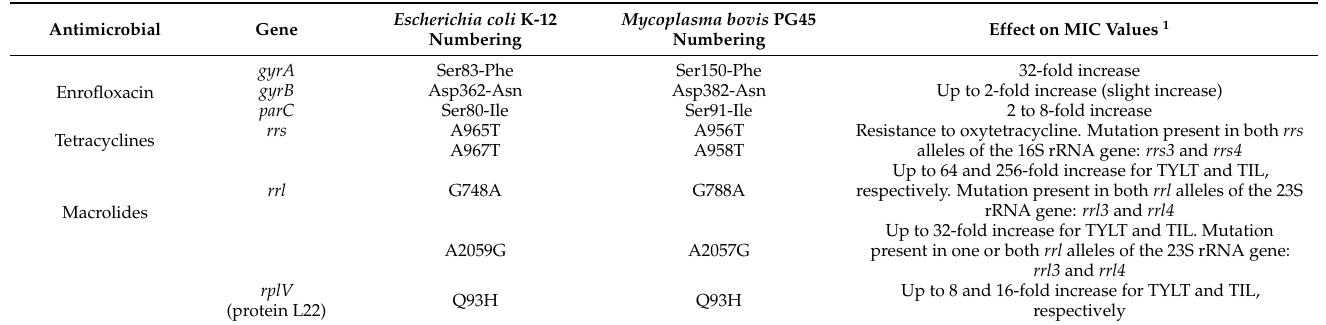
Table 4. Nucleotide mutations or amino acid changes associated with increased MIC values in Mycoplasma bovis isolated from western Canadian beef